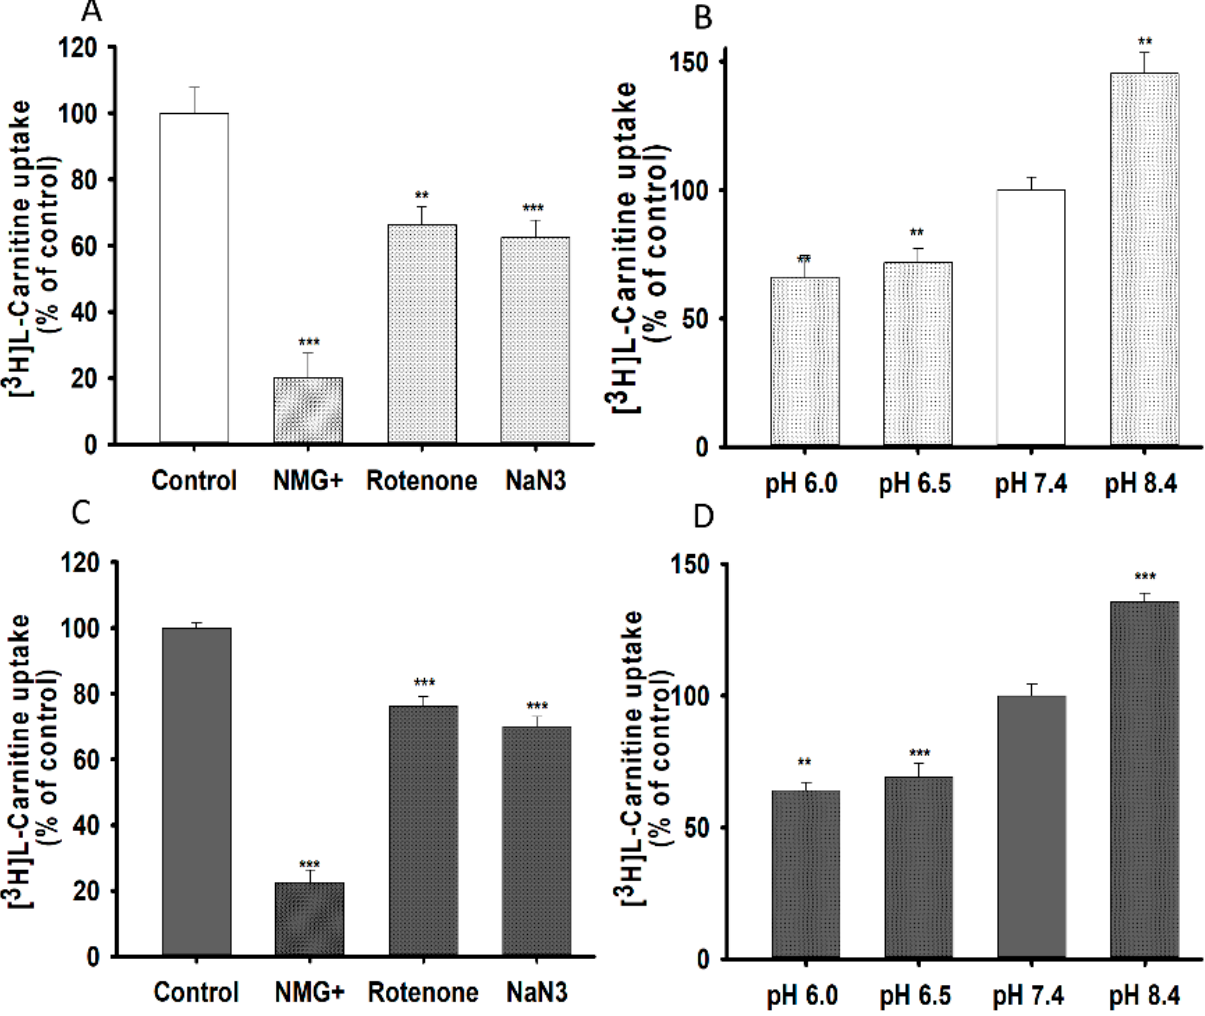
Figure 3. Sodium, energy and pH dependent uptake of [ 3 H]L-carnitine in NSC-34 cell lines in 15 min at 37 ◦ C. Sodium azide (0.1%) and rotenone (25 µ M) pretreatment was carried out for 20 min to deplete ATP. To test for sodium dependency, Na + in transport buffer was replaced by NMG+ and pH dependency was tested for pH ranging from 6.0 to 8.4 and uptake was conducted in WT ( A , C ) and MT ( B , D ) cell lines. Each data represents the mean ± S.E.M ( n = 4). *** p < 0.001 and ** p < 0.01 indicate significant differences from the control.